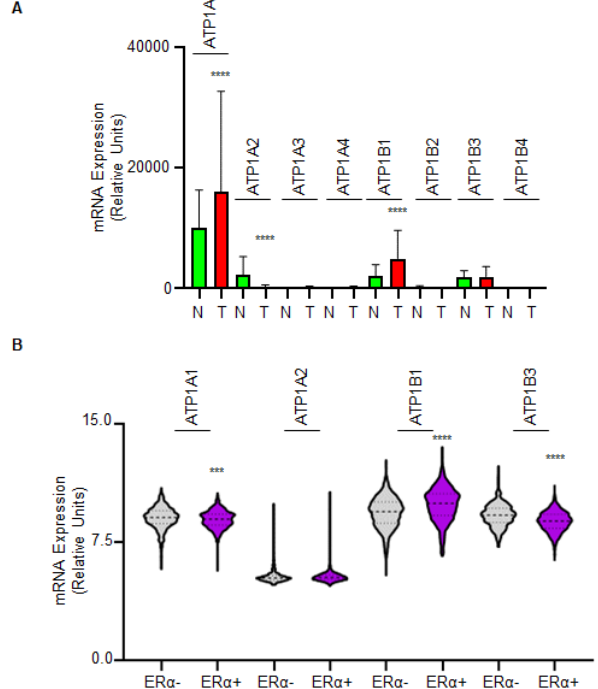
Figure 3. The expression of the Na/K ATPase isoforms in normal and tumor tissue. ( A ) RNAseq analyses as retrieved by the https://tnmplot.com/analysis (accessed on 1 July 2022) web portal of the indicated genes in normal (N; the number of samples: 403) and tumor (T; the number of samples: 1097) tissues. Original data are given in Supplementary Table S2. ( B ) mRNA expression analyses for the indicated genes as extracted by the https://www.cbioportal.org/ (accessed on 1 July 2022) database and stratified according to estrogen receptor α (ER α ) expression. Original data are given in Supplementary Table S3. Stratification was done considering the luminal tumors as ER α -positive [1] (ER α +; the number of samples: 1140) and all the others as ER α -negative (ER α -; the number of samples: 758). **** ( p < 0.0001) and *** ( p < 0.001) indicate significant differences, calculated with the Student t-test with respect to the N or ER α -